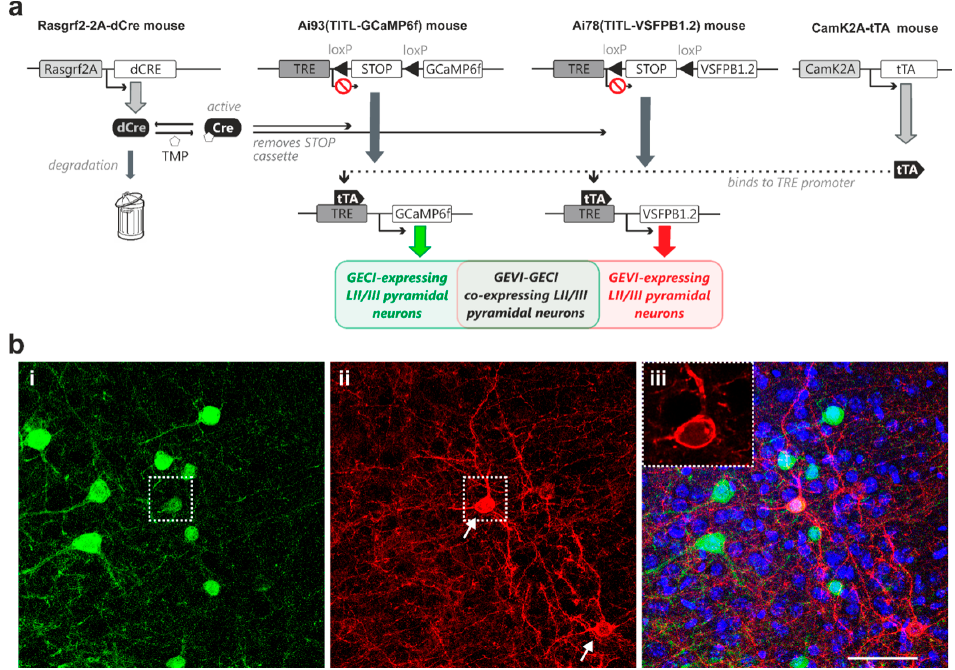
Figure 3. Dual-controlled co-expression of GECI (GCaMP6f) and GEVI (VSFP Butterfly 1.2) in somatosensory cortical layer II/III pyramidal neurons in vivo. ( a ) The combination of dCre and tTA allows for dual control of Ai78 VSFP Butterfly 1.2 and Ai93 GCaMP6f expression probabilities. This transgenic strategy resulted in GECI-expressing, GEVI-expressing and GECI/GEVI co-expressing populations. ( bi ) Strong GCaMP6f fluorescence signal observed in perisomatic regions of individual pyramidal neurons. ( ii ) Strong VSFP Butterfly 1.2 fluorescence signal observed in the membranes of two pyramidal neurons (arrows). ( biii ) Merged GCaMP6f (green) and VSFP Butterfly 1.2 (red) fluorescence signals on DAPI nuclei counterstaining (blue) showing sparse Golgi staining-like indicator expression pattern. Inset: a single-plane confocal image of the indicator-expressing neuron, outlined by the dotted box in ( bii ), showing optimal GEVI membrane targeting. Note this cell co-expresses GCaMP6f and VSFP Butterfly 1.2. Scale bar = 50 µm.